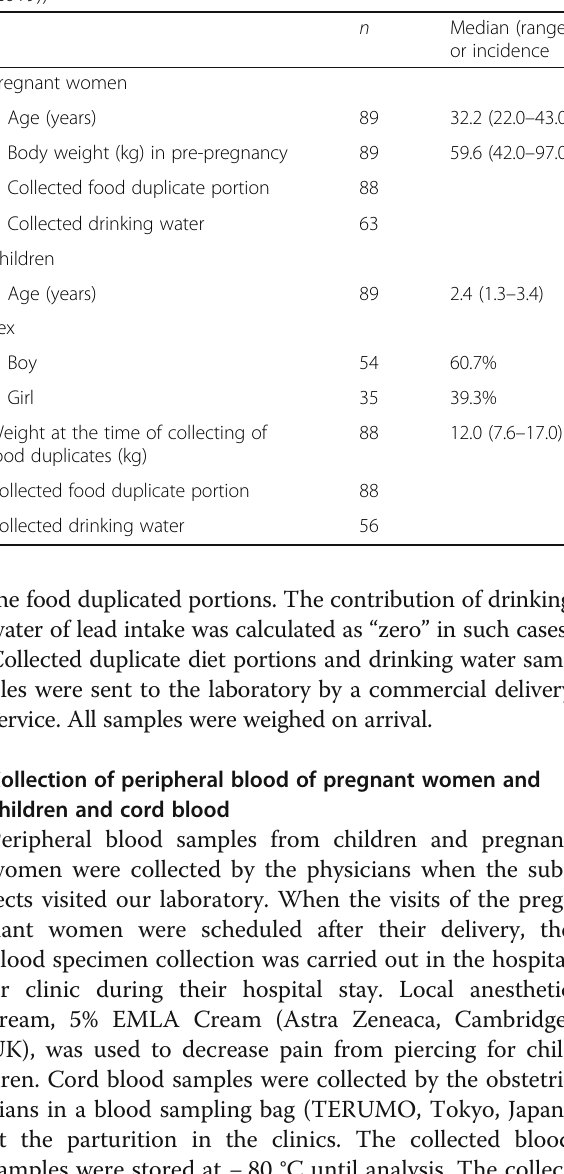
Table 1 Summary of the familial condition of participating pregnant mothers and children (modified from Mise et